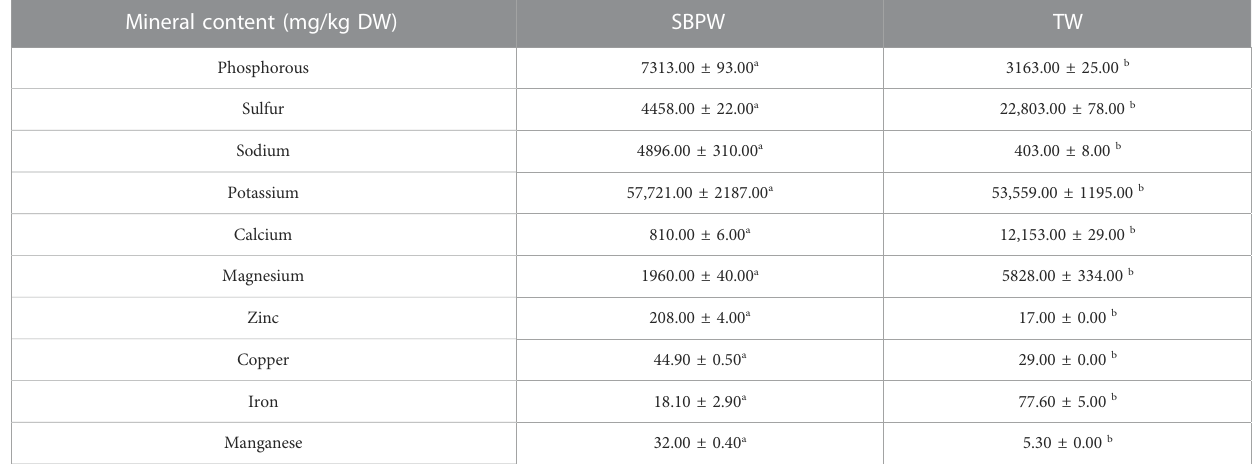
TABLE 2 Mineral content (mg/kg dry weight) of SBPW and TW. Data in the same row that do not share the same letter are signi fi cantly different ( α